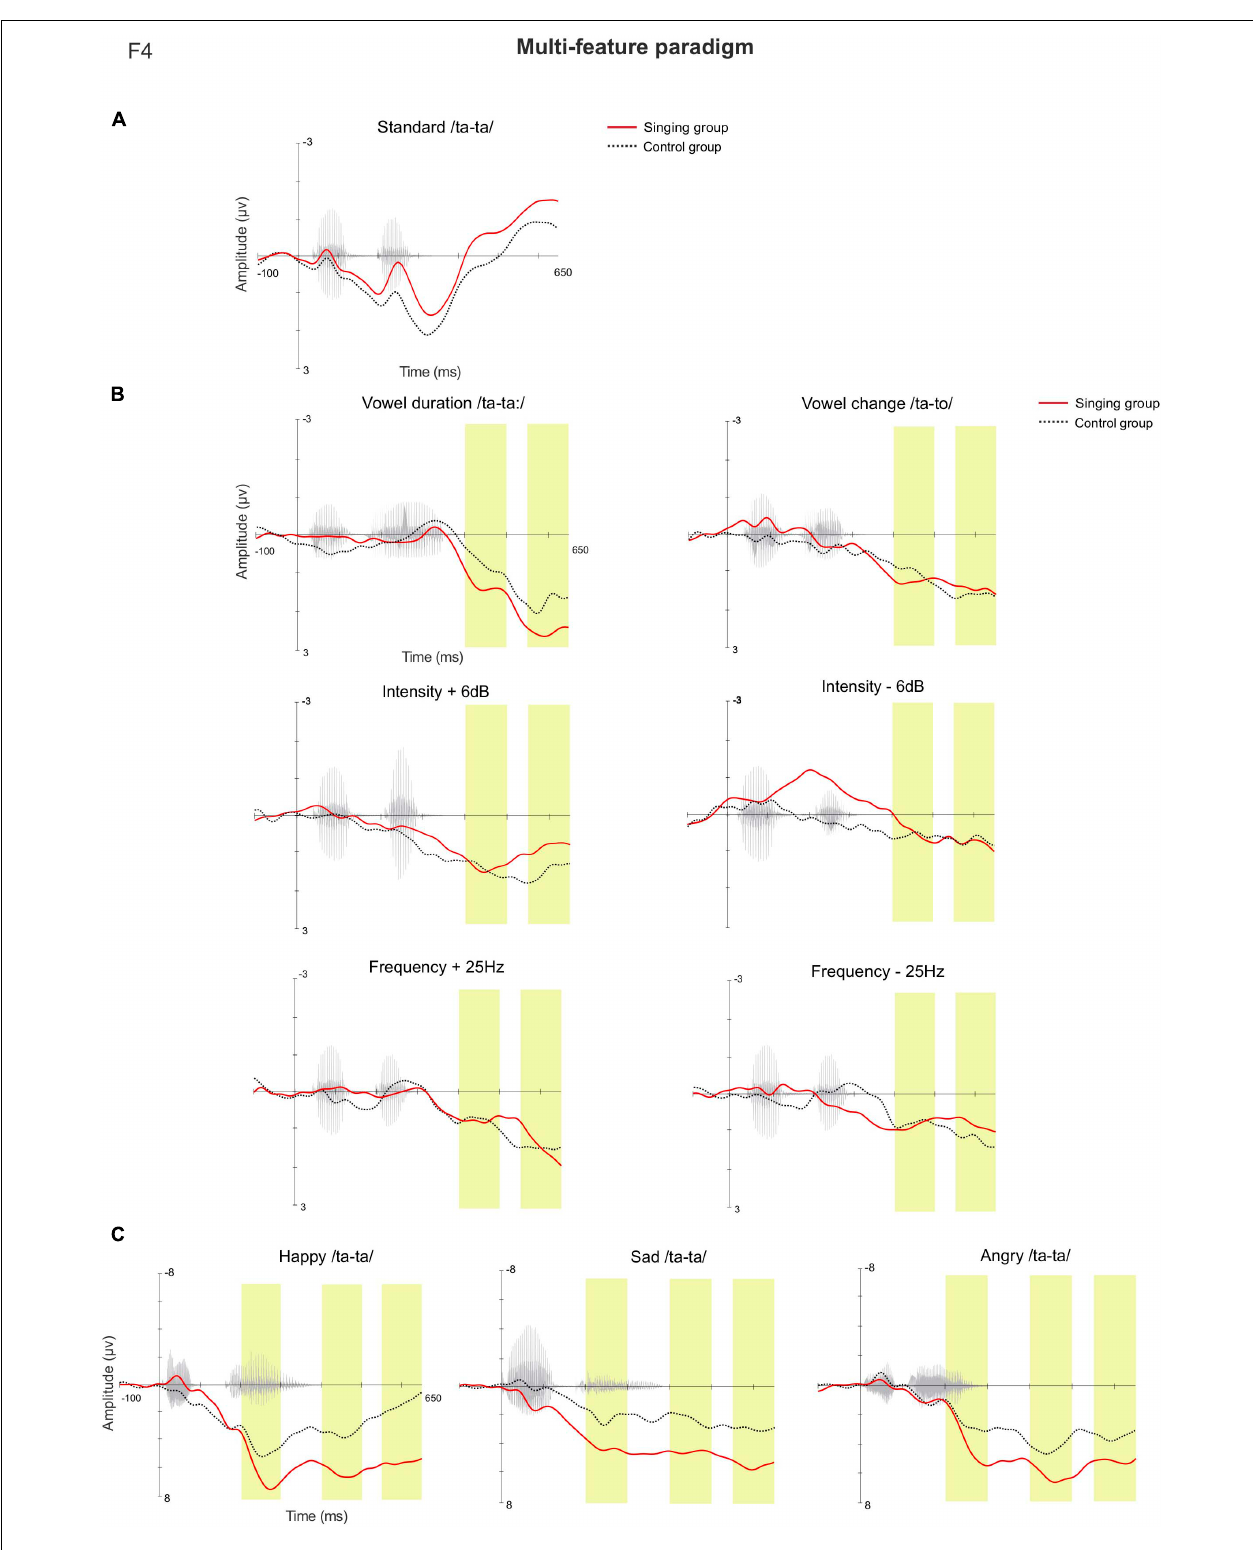
FIGURE 4 | The AERP waveforms between the singing intervention and control group in the multi-feature paradigm at the electrode F4 for (A) the standard stimulus, (B) the standard-subtracted waveforms for both the phonetic deviants, and (C) the emotional stimuli. The yellow bars highlight the examined latency windows 200–300, 400–500, and 550–650